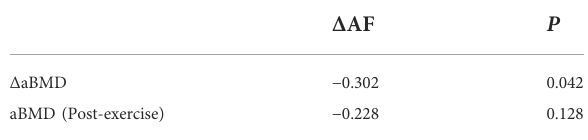
TABLE 4 Correlation analysis between Δ AF and BMD-related indicators.